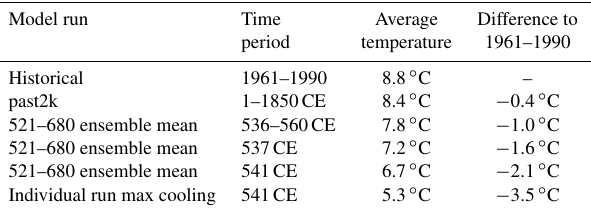
Table 1. Average temperature in Scandinavia for different ensemble members and